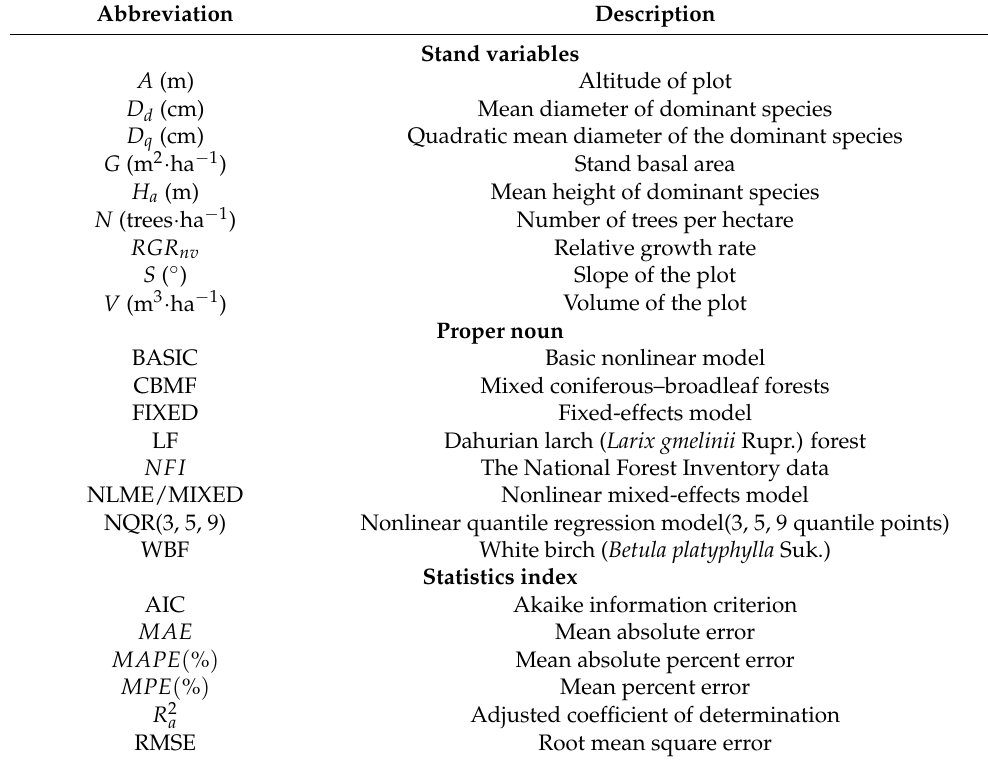
Table 1. Descriptions of the main variables and terms for the three forest types in the eastern Daxing’an Mountains, Northeast China.